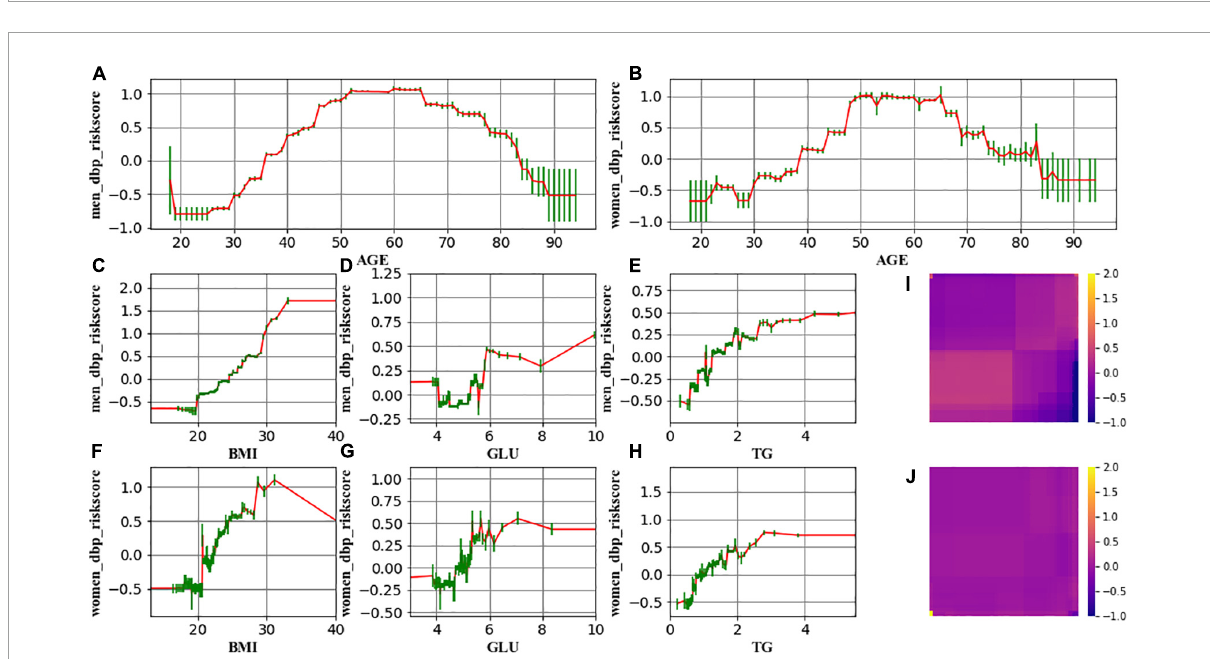
FIGURE3 The change in the risk of high DBP related to age ( A for men and B for women), BMI ( C for men and F for women), GLU ( D for men and G for women), and TG ( E for men and H for women). (I,J) Demonstrate that the interaction effect is marginal. Red lines represent the spline-based GAM curves. Green lines represent the confidence